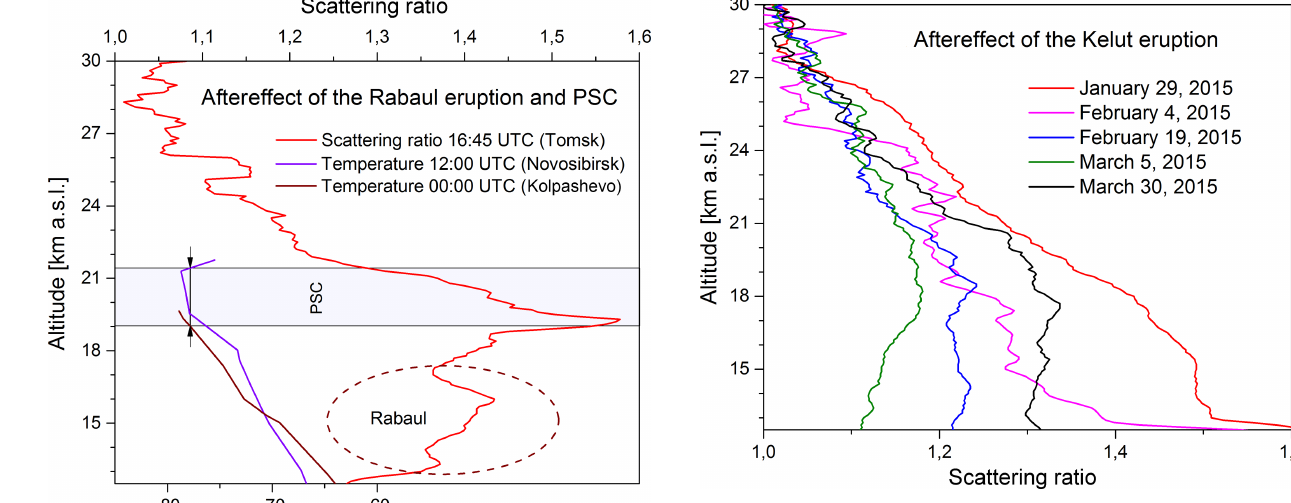
Figure 15. Perturbed scattering ratio profiles retrieved from the SLS aerosol lidar measurements between 29 January and 30 March